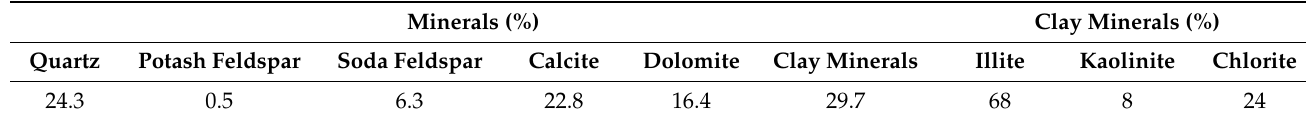
Table 1. XRD experimental results of sandstone samples.